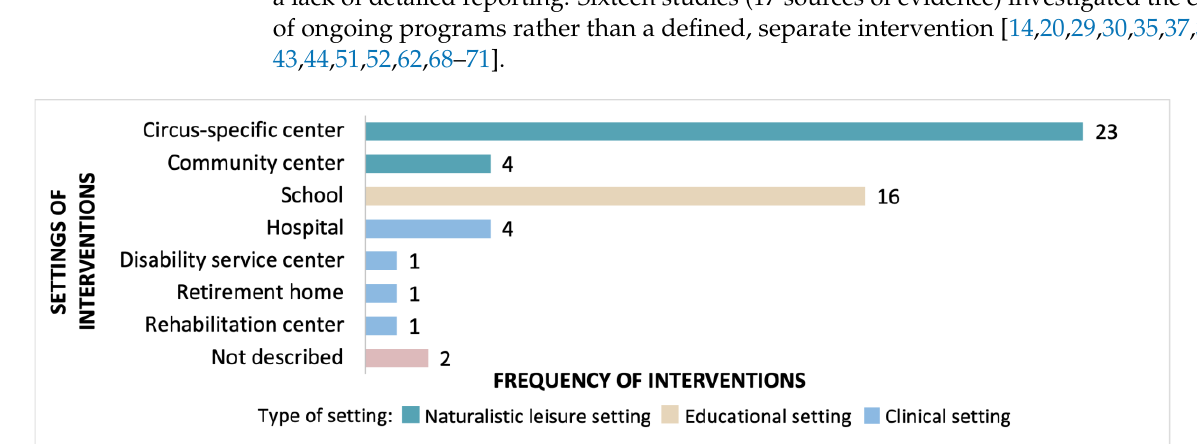
Figure 4. Settings utilised in circus interventions.